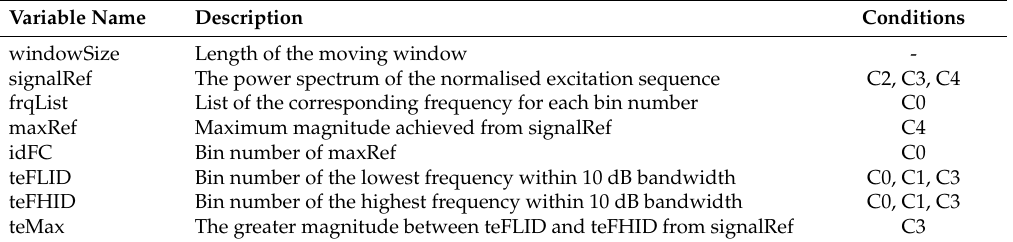
Figure 2. Flowchart of the initialisation. Table 1. Description of variables extracted from the